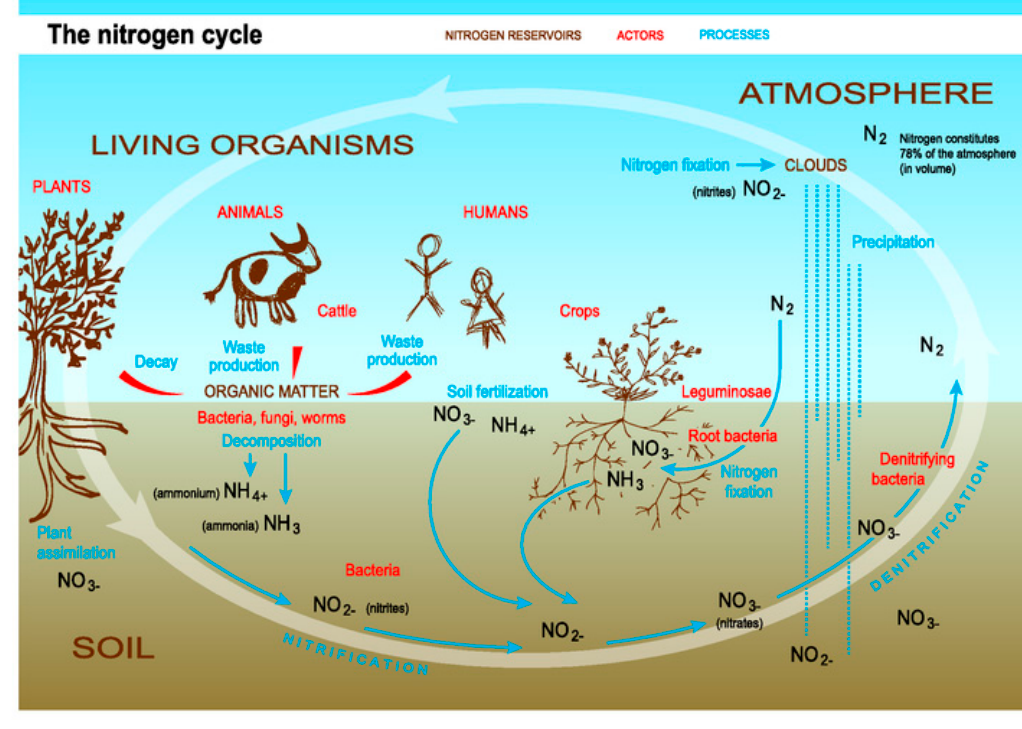
Figure 1. Global nitrogen cycle [5].